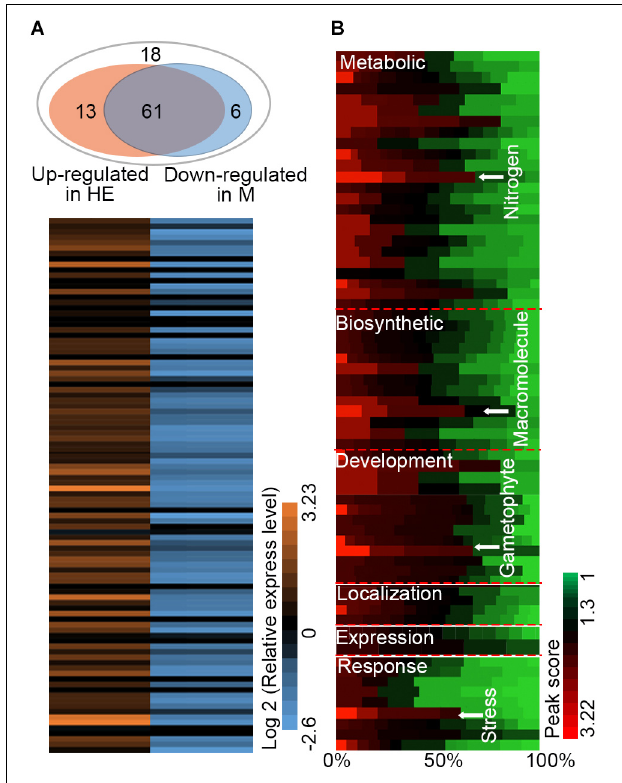
FIGURE 3 | Candidate target genes of EsNAC1 in Arabidopsis . (A) The expression analysis of 98 EsNAC1 candidate target genes (FDR ≤ 0.05, Peak score [–log 10 ( P -value) ≥ 1.3] in the HE line compared with that of corresponding genes in the M line. HE1 line and M2 line were sampled with three biological replicates for RT-qPCR. Sixty-one genes that increased expression [relative expression level (REL, log 2 ratio) ≥ 1] in the HE line showed reduced expression (REL ≤ –1) in the M line. All data were normalized to the target gene expression level in Col-0. (B) Binding situation of EsNAC1 quantified by the percent of genes ( x -axis) in different gene ontologies ( y -axis) with the color of each square mapped to the peak scores. Peak score: –log 10 ( P -value) for each basepair through local Poisson test, which means the ChIP signal at each basepair will be tested against the whole genome background of Arabidopsis , and the ratio of Peak score IP /Peak score input was